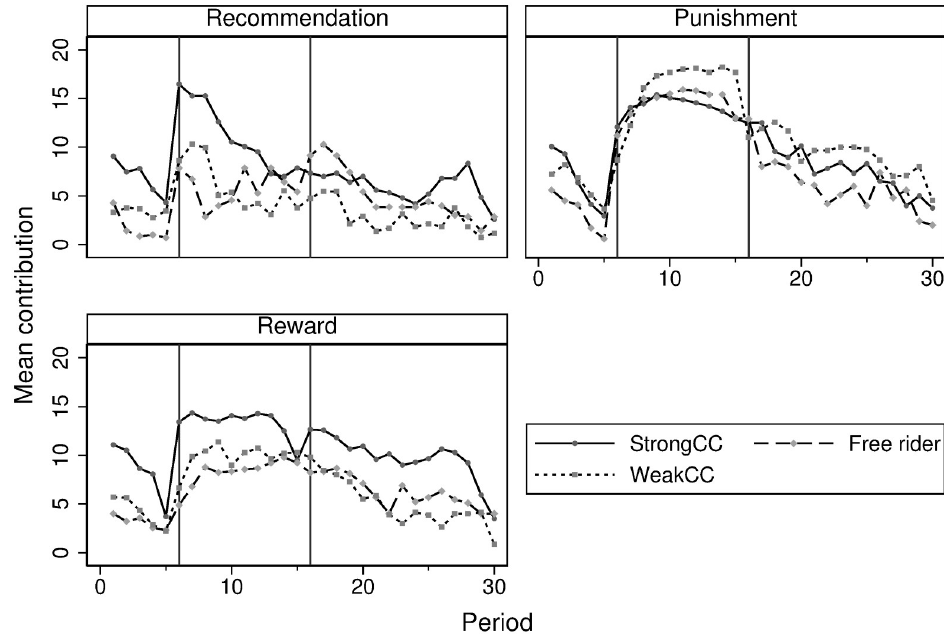
Fig 3. Average contributions in the